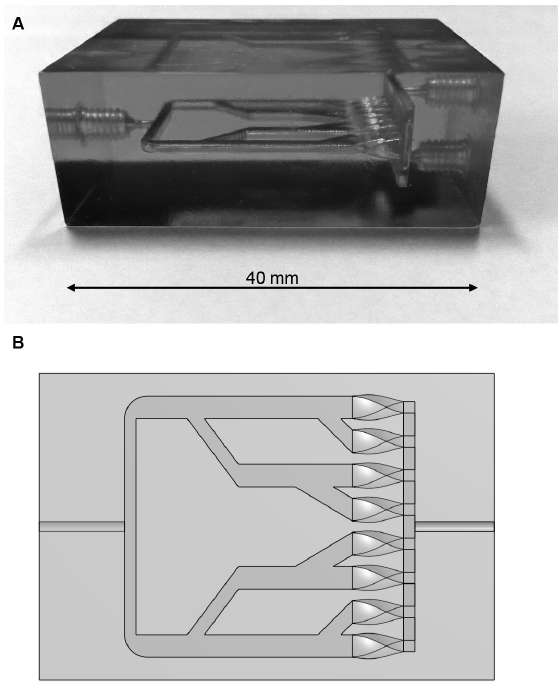
Figure 2. ( A ) Custom built 3D-printed plexiglass mixing device. ( B ) Technical drawing of the mixing